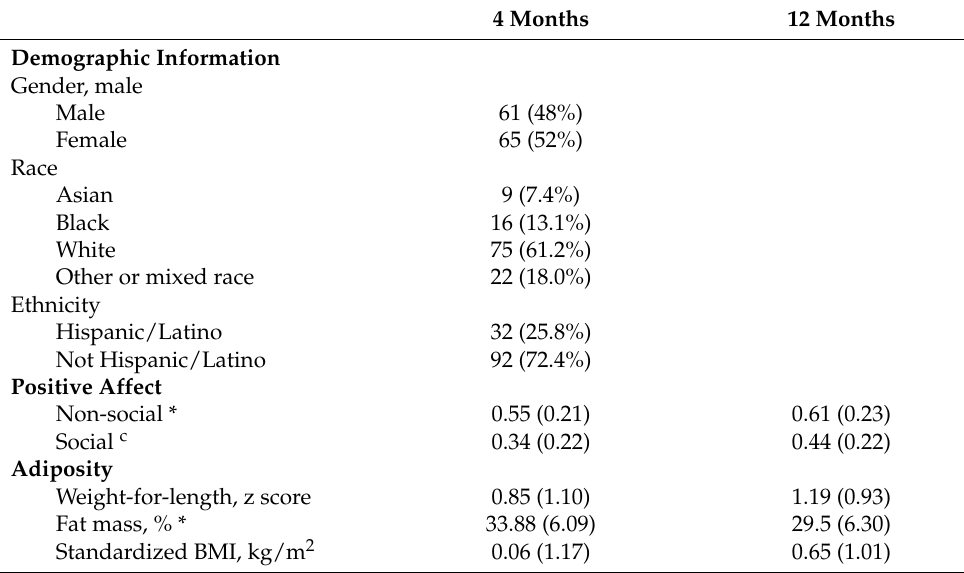
Table 1. Demographic, temperament, and adiposity information by age.